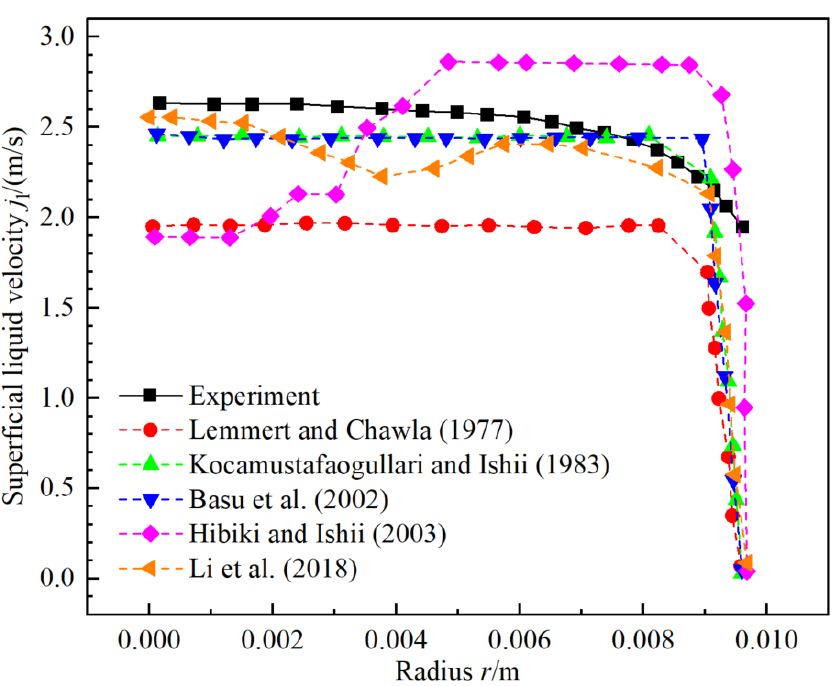
Figure 9. Superficial liquid velocity j l distribution of various typical models of N n with model of D d [8], f [46], a ( d i , d j ) [57], Ω ( V p ), β ( f bv , 1) [54], and DEBORA-1 experiment ( P = 2.62 MPa) [28] at z = 3.5 m.